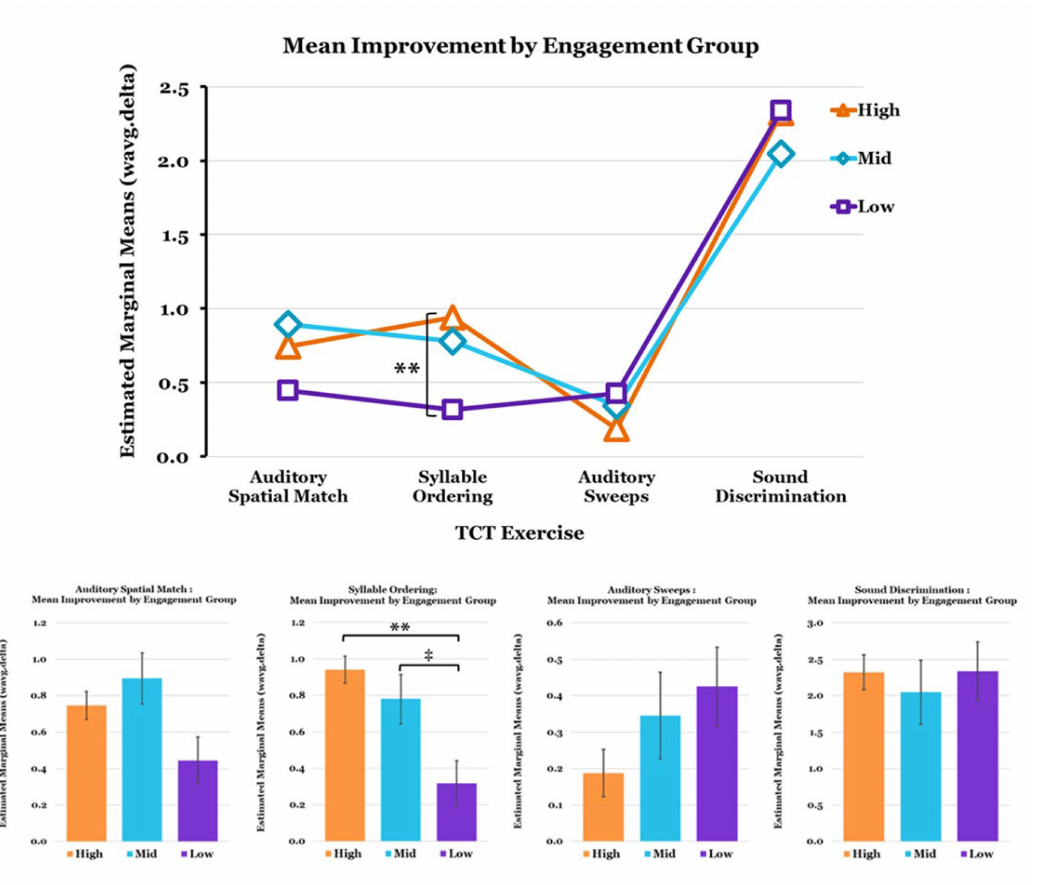
Figure 5. Mean Improvement on TCT Exercises (wavg.delta) by TSC Analysis-Based Engagement Sub-Groups. Covariates appearing in the model are evaluated at the following values: Age = 17.0,